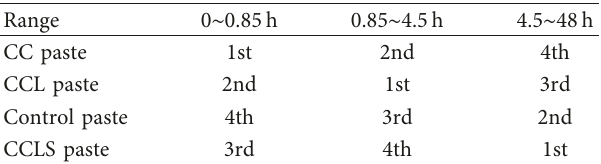
Table 2: The comparison about the heat evolution rate of four